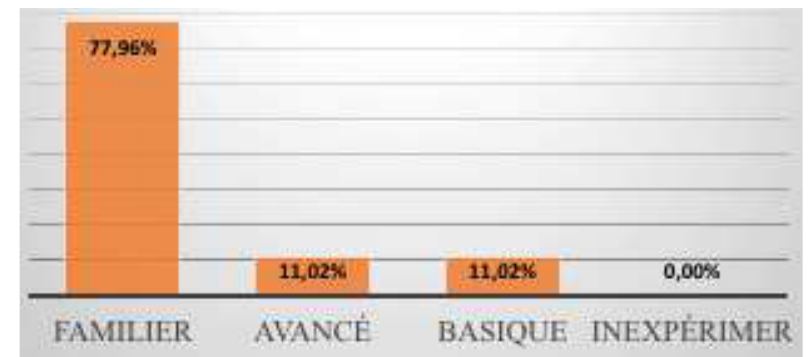
Fig. 6. Représentations sur le degré de maîtrise des compétences numériques techniques.